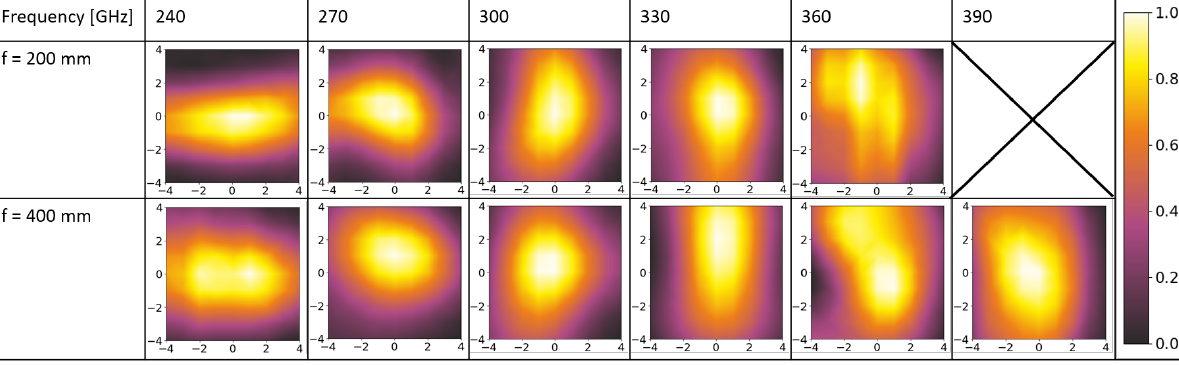
Figure 7. Intensity distributions of focal spots obtained for range of frequencies for DOEs with f = 200 mm and f = 400 mm. Presented intensities were cropped to size of 4 mm × 4 mm to show the shape of focal spots. Each intensity distribution was normalized to the maximum value registered while scanning a particular focal spot. Power emitted from the source depends on the frequency; therefore, intensities of the focal spots cannot be compared